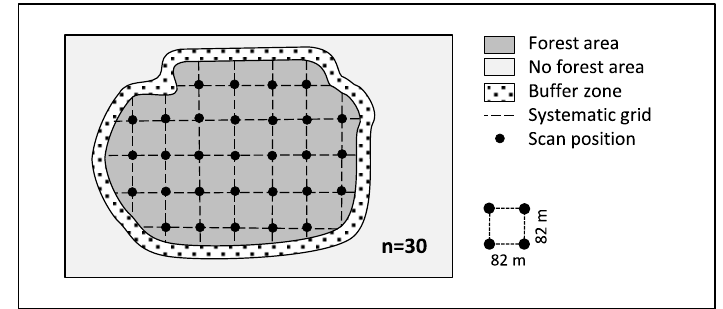
Figure 2. Sampling design for an exemplary plot (Forest area = ~20 ha).